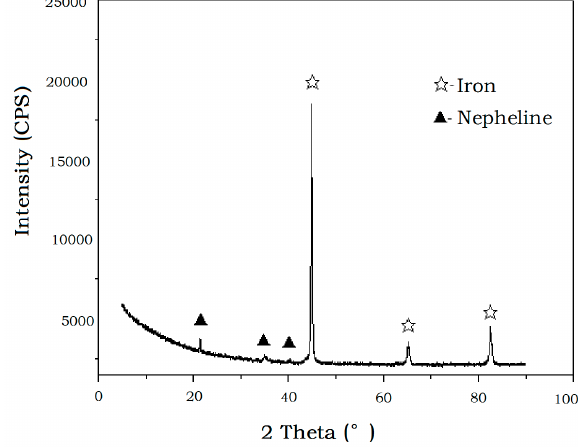
Figure 10. XRD pattern of iron powder.